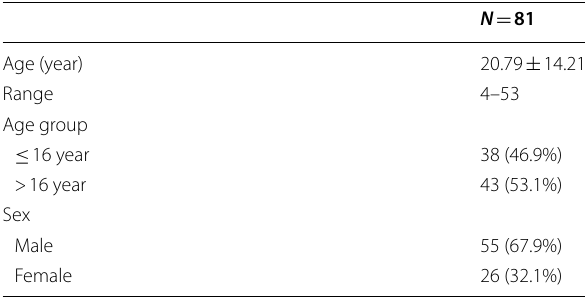
Data were expressed in form of frequency (percentage), mean (SD),